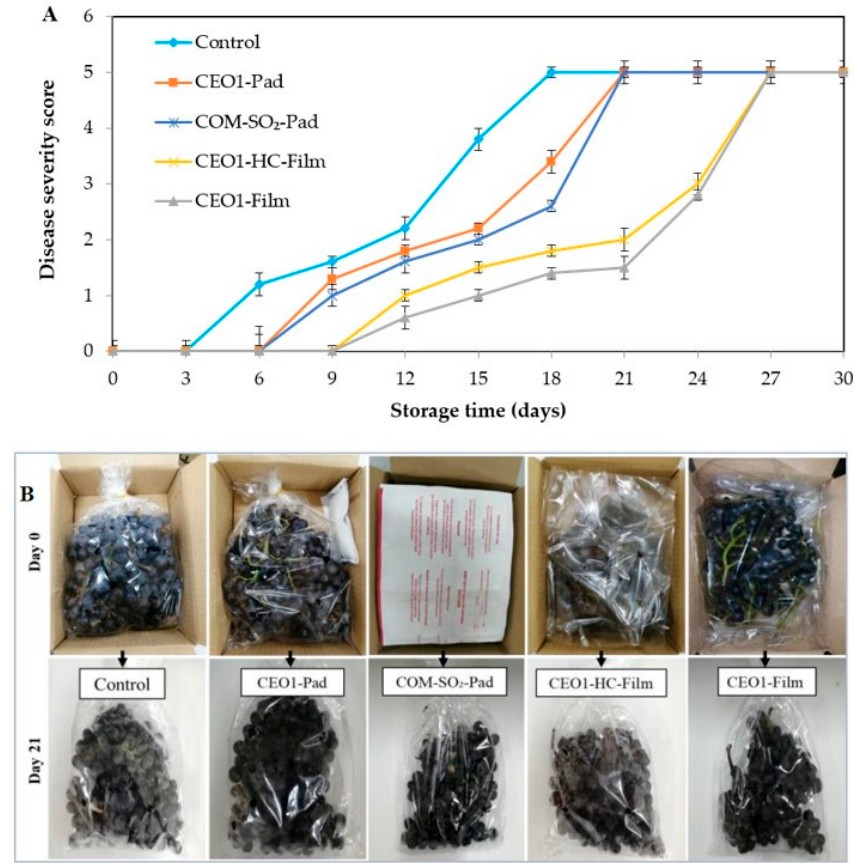
Figure 2. Disease severity ( A ) and photographs ( B ) of TG without and with CEO antifungal packag- ing. Values are mean ± standard deviation (n = 10). TG: table grape; CEO: clove essential oil; Control: TG without any treatment; CEO1-Pad: TG with 1% CEO pad; COM-SO 2 -Pad: TG with commercial sulfur dioxide pad; CEO1-HC-Film: TG wrapped with a film composed of 1% CEO and halloysite clay; CEO1-Film: TG wrapped with 1% CEO